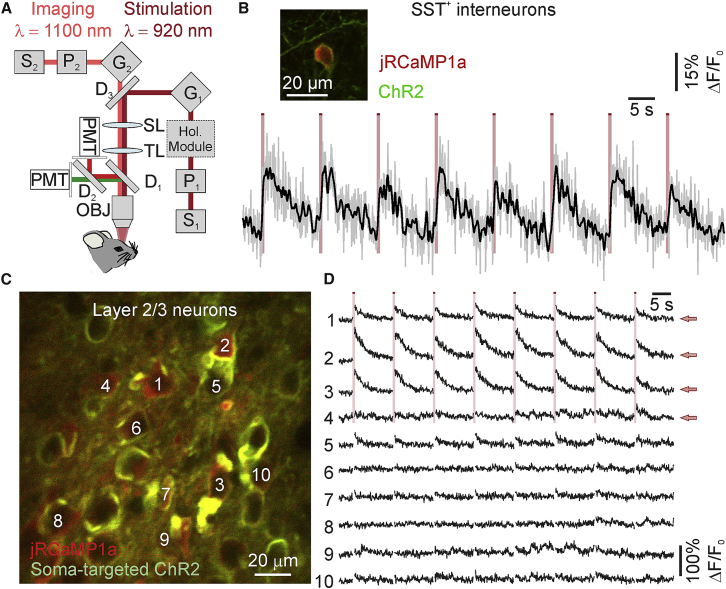
Simultaneous Two-Photon Imaging of Red-Shifted Indicator and Two-Photon Holographic Stimulation of Blue-Shifted Excitatory Opsin In Vivo(A) Schematic of the optical setup for simultaneous two-photon imaging (λexc = 1,100 nm) and two-photon holographic illumination (λexc = 920 nm). S1, stimulation laser source; S2, imaging laser source; P1–2, Pockels cells; G1–2, galvanometric mirrors; SL, scan lens; TL, tube lens; D1–3, dichroic mirrors; PMT, photomultiplier tube; OBJ, objective; Hol. Module, holographic module (comprising the SLM, the λ1/2, and L1–4 displayed in Figure 1).(B) Calcium transients in a SST+ interneuron during simultaneous two-photon imaging (λ = 1,100 nm; laser power: 25 mW; frame rate: 11 Hz; scanned area: ∼90 × 90 μm2) and holographic stimulation (λ = 920 nm; laser power: 50 mW). ΔF/F0 (gray trace) was smoothed with a moving average filter (black trace). The inset shows one layer 2/3 SST+ interneuron co-expressing ChR2-eYFP (green) and jRCaMP1a (red).(C) Two-photon image showing layer 2/3 neurons expressing soma-targeted ChR2-eYFP (green) and jRCaMP1a (red) in vivo.(D) Calcium transients recorded from jRCaMP1a-positive cells (imaging power: 30 mW; frame rate: 11 Hz). The numbers on the left refer to the neurons indicated in (B). Neurons 1–4 (red arrows) were simultaneously stimulated with four elliptical shapes covering the cell somata. Each stimulation episode is indicated by a red bar (stimulation power per cell: ∼50 mW). Periods of stimulation are blanked (see Experimental Procedures).See also Figures S6 and S7.